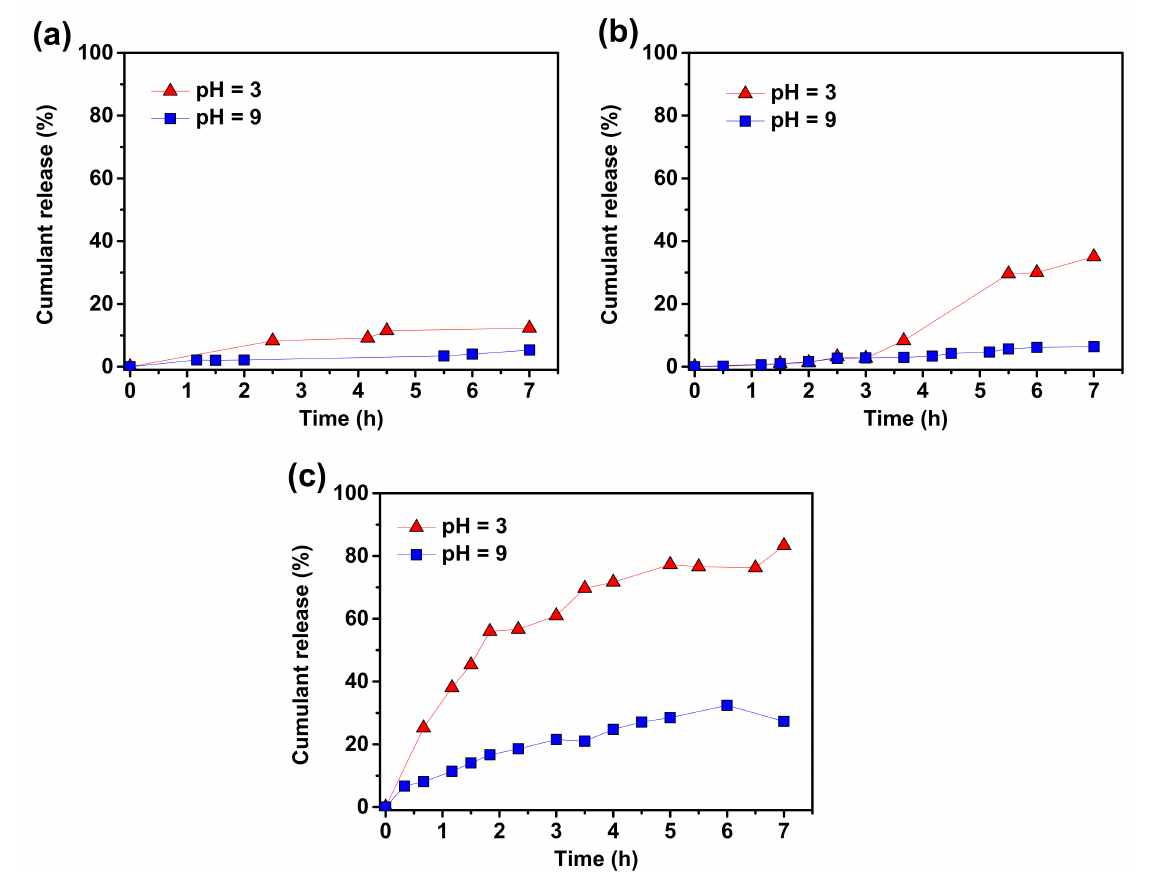
Figure 7. In vitro release profile of quercetin from QC-loaded monomolecular micelles composed of macromolecules with ( a ) 49, ( b ) 73, and ( c ) 98 DMAEMA mers in side chains incubated in aqueous solutions at 37 ◦ C. The measurements conducted for kinetics samples from the synthesis shown in Table 1, entry 4; details in Table